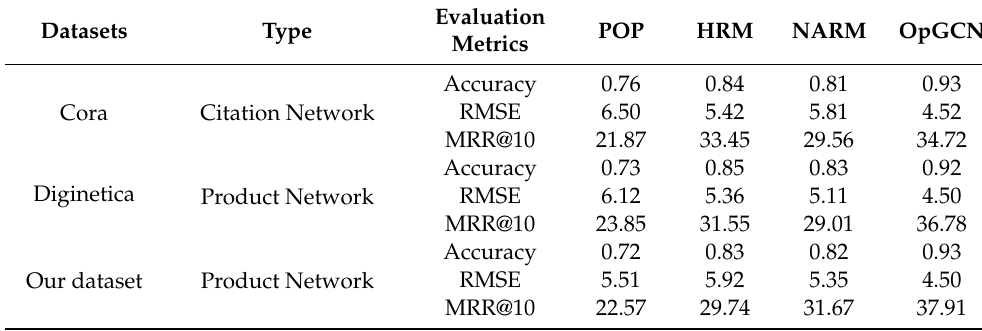
Table 7. Performance comparison of di ff erent baseline methods on di ff erent datasets.